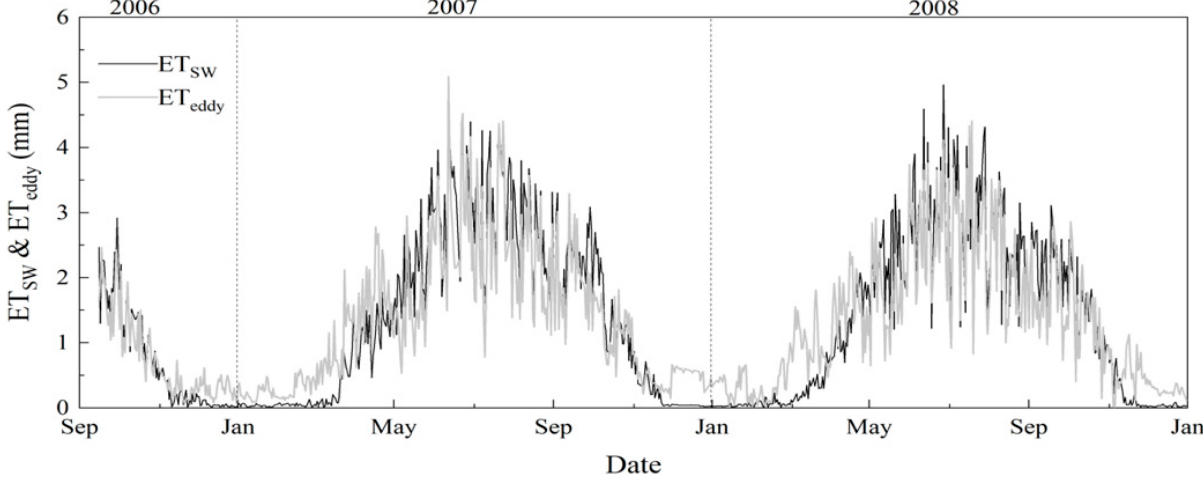
Figure 9. Comparison of the seasonal variations between evapotranspiration estimated by the S–W model ( ET SW ) and measured by the eddy covariance method ( ET eddy ) for 2006–2008.